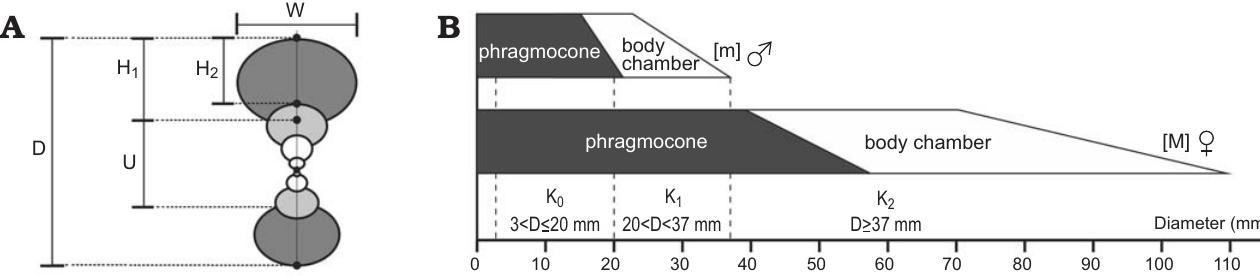
Fig. 3. A . Dimensions considered for description of the ammonite morphology. D, diameter; H 1 , whorl height; H 2 , ventral (or apertural) whorl height; U, umbilical width; W, whorl width. B . Comparative representation of the ontogenies of the sexual dimorphs with indication of the developmental stages (K 0 , K 1 , and K 2 ) considered for statistical comparison of the ontogenies (definitions in the text). All values representing the studied material.